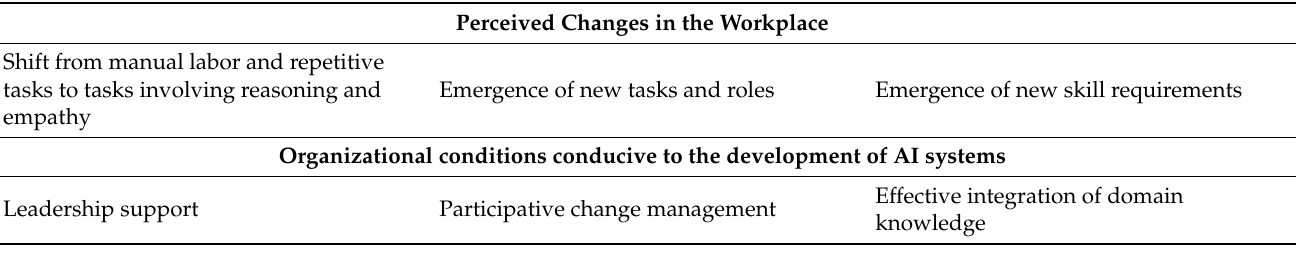
Table 2. Overview of